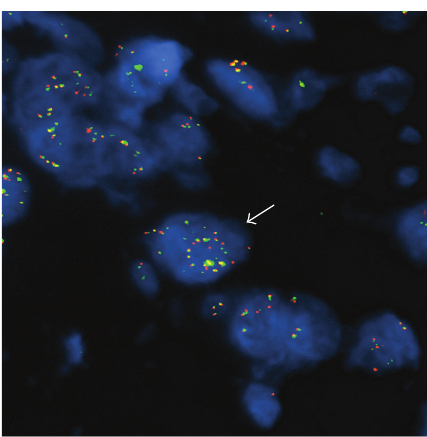
Figure 4: FISH results using a MYC break-apart probe. Repre- sentative tumor cell (indicated by arrow) is showing an increased number of fusion signals (more than 20), indicative of high-level amplification of the MYC